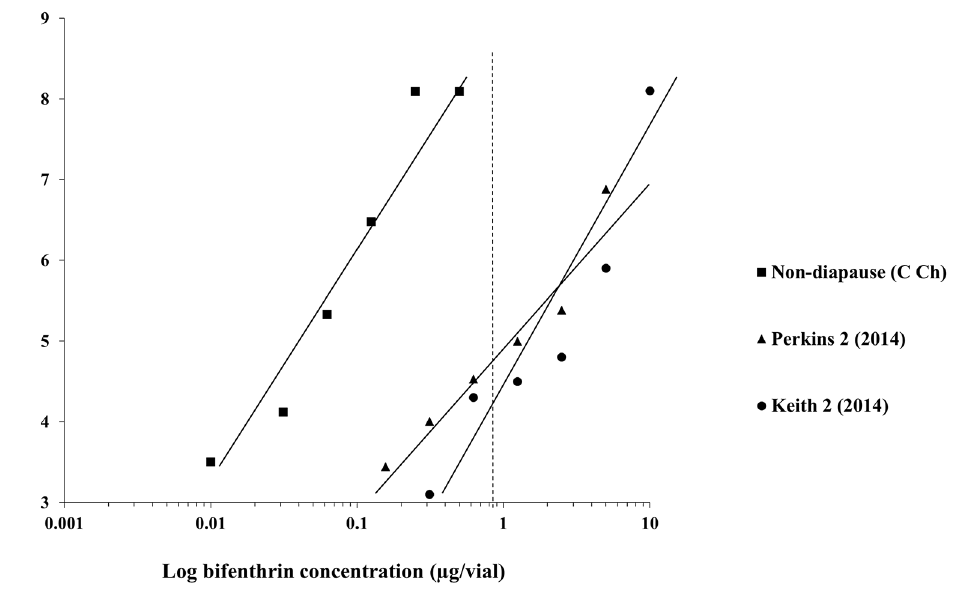
Fig 4. Probit mortality plots of bifenthrin determined by lethal concentration bioassays for adult WCR field populations from Keith and Perkins Counties, NE and a non-diapause laboratory colony (CCh) considered susceptible. Field collections and bioassays performed in 2014. Vertical dash- line represents the diagnostic concentration (LC 99 ) of 0.77 μ g/vial calculated from the 10 pooled lab colonies (Table 1).